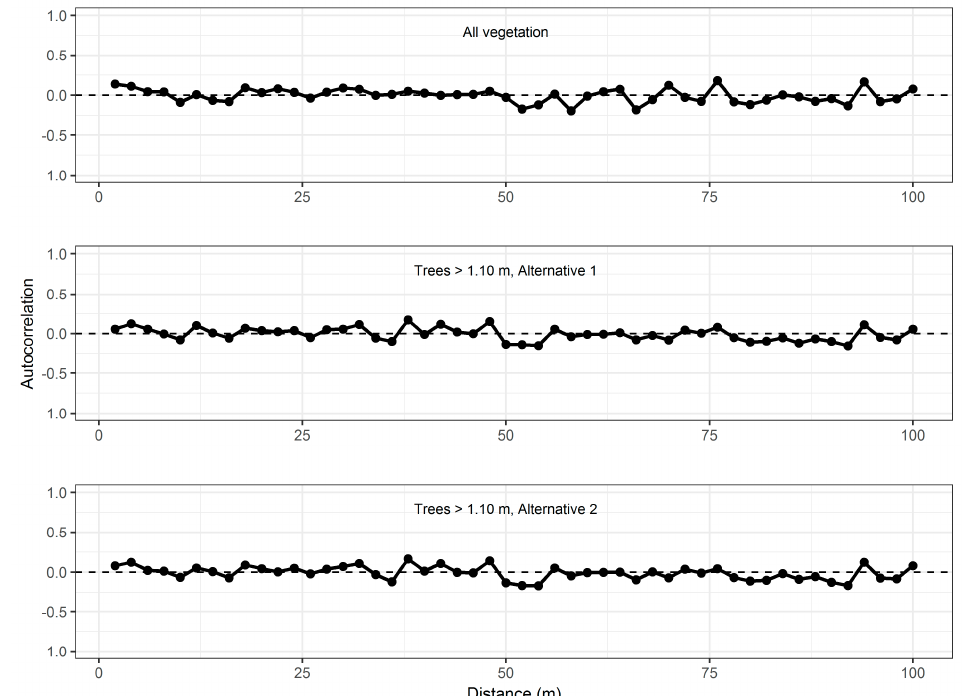
Figure 4. Autocorrelation of observed residuals across the entire study area (solid lines) and predicted autocorrelation (dotted lines) for model of change in vegetation height ( top ) and change in height of trees ≥ 1.10 m in height according to Alternative 1 ( middle ) and Alternative 2 ( bottom ).